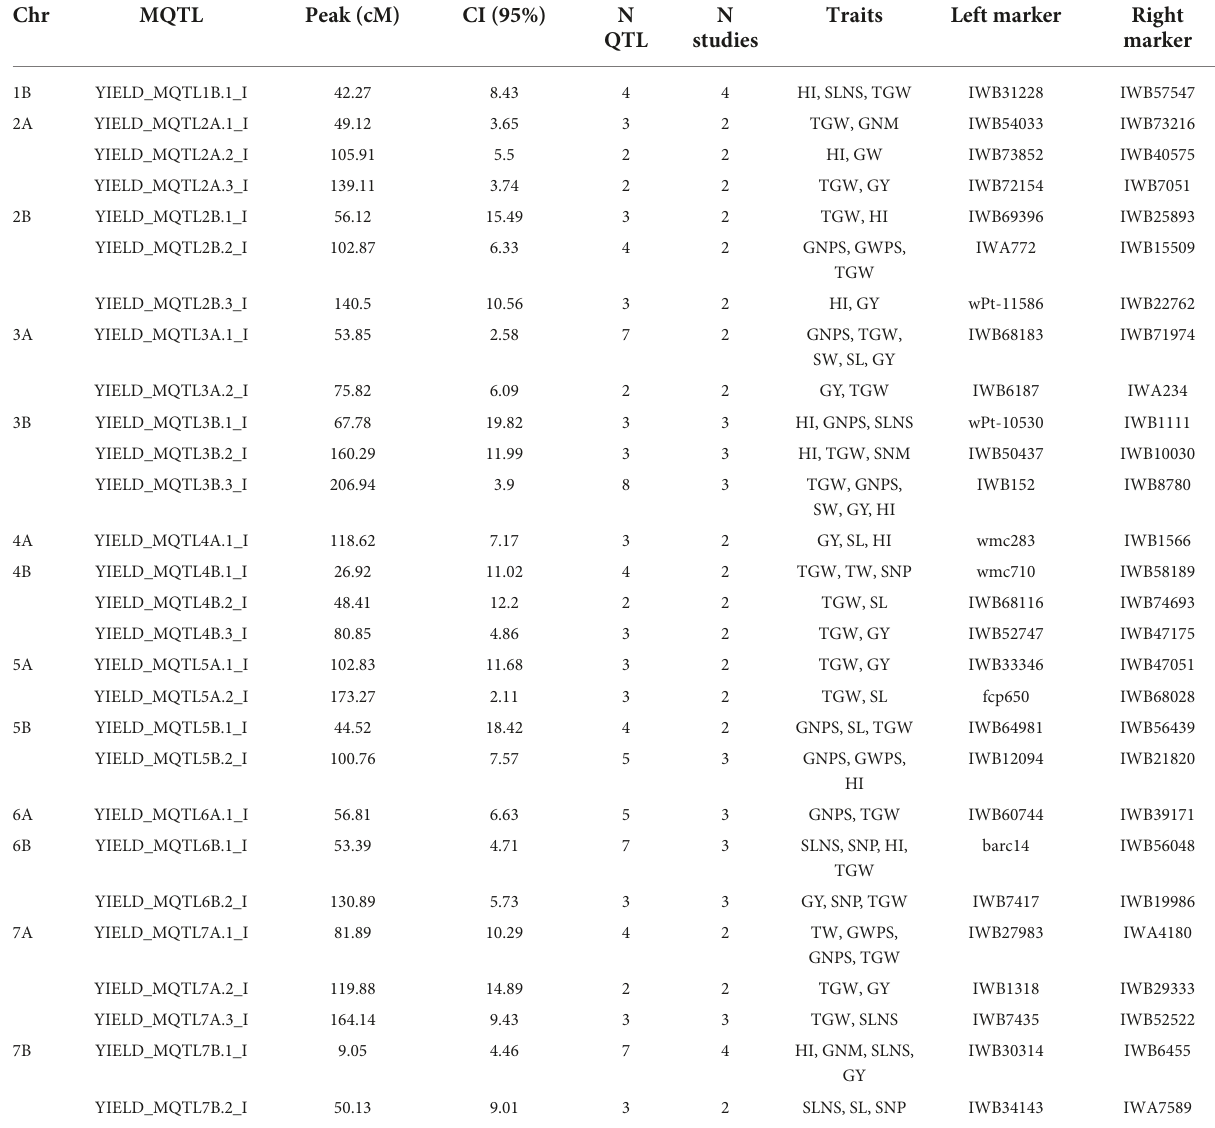
TABLE 3 Characterization of MQTL under irrigated